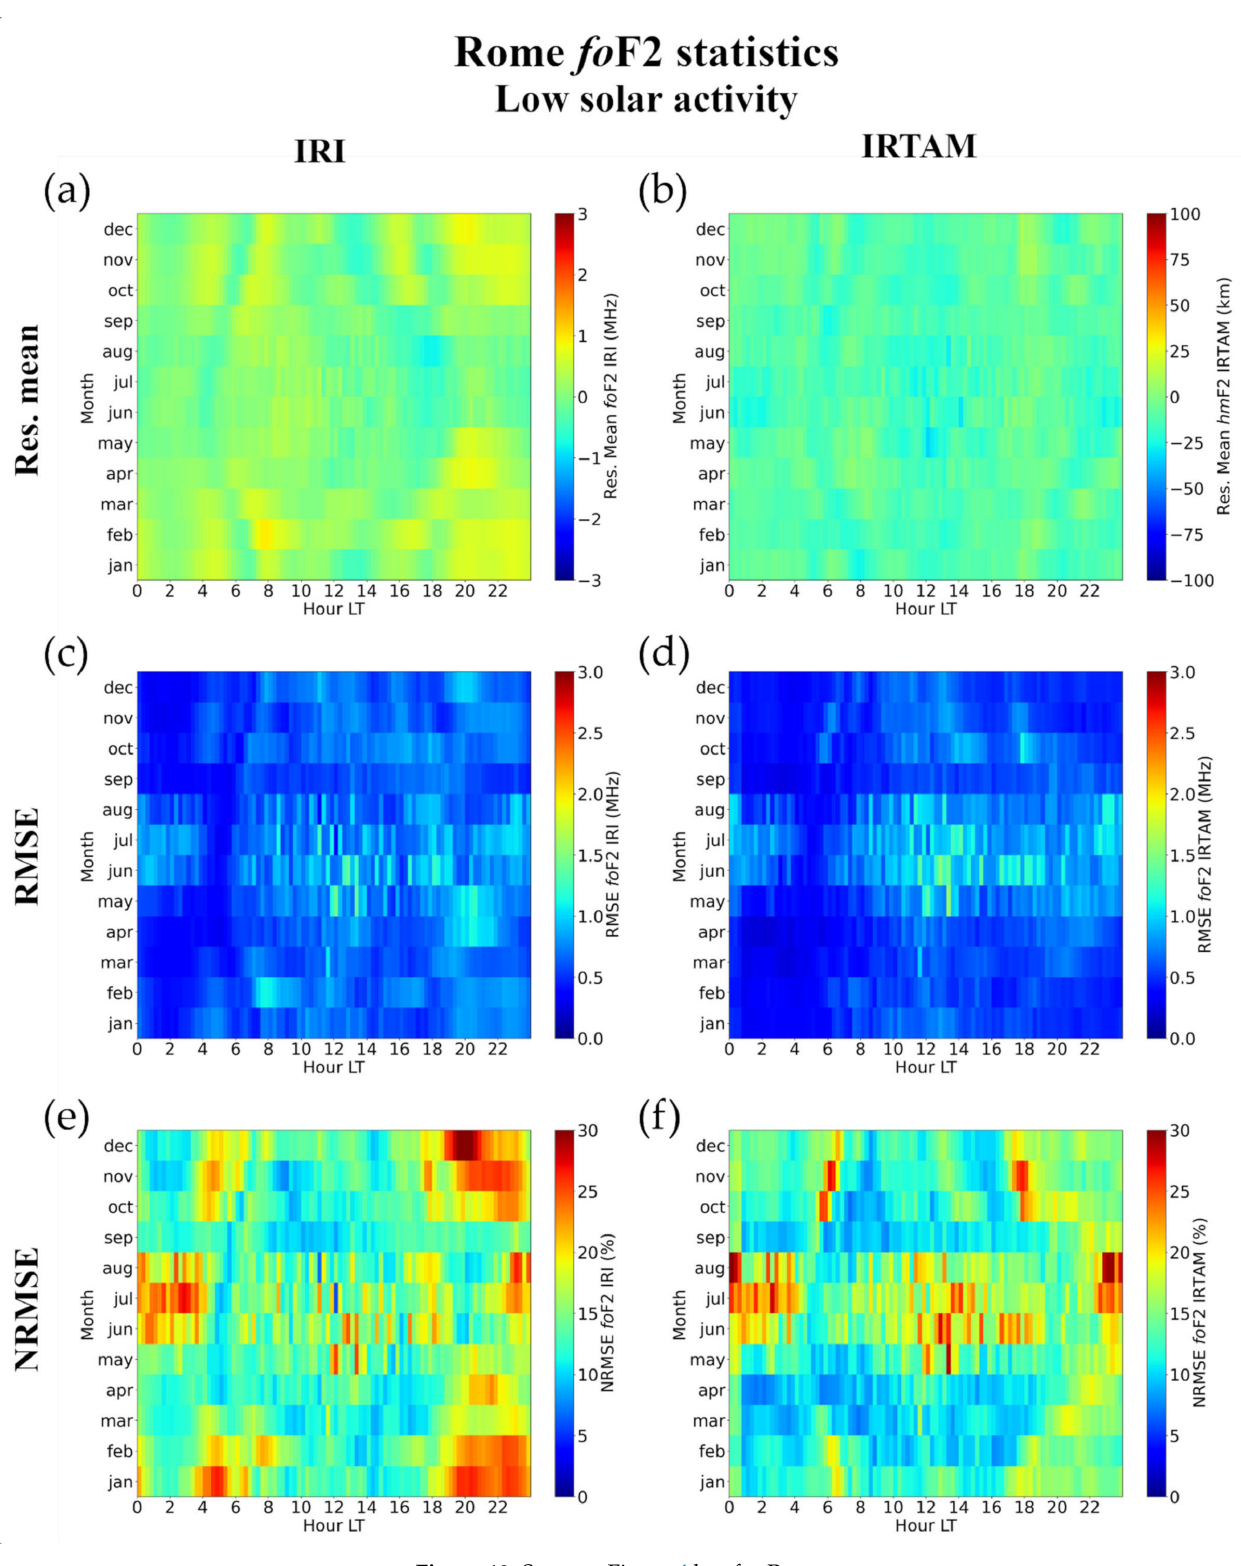
Figure 10. Same as Figure 4 but for